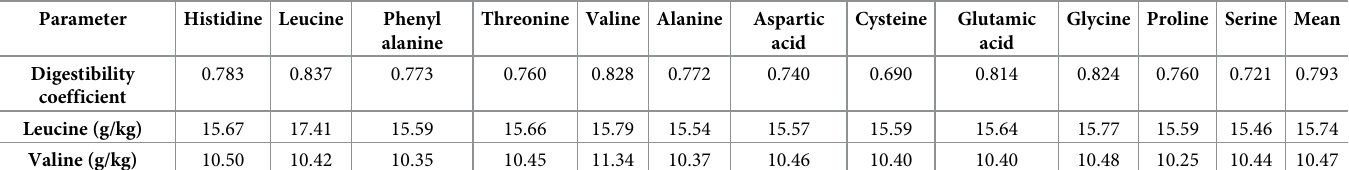
Table 14. Estimated maximum digestibility coefficients by dietary leucine and valine levels at 28 days post-hatch. Parameter